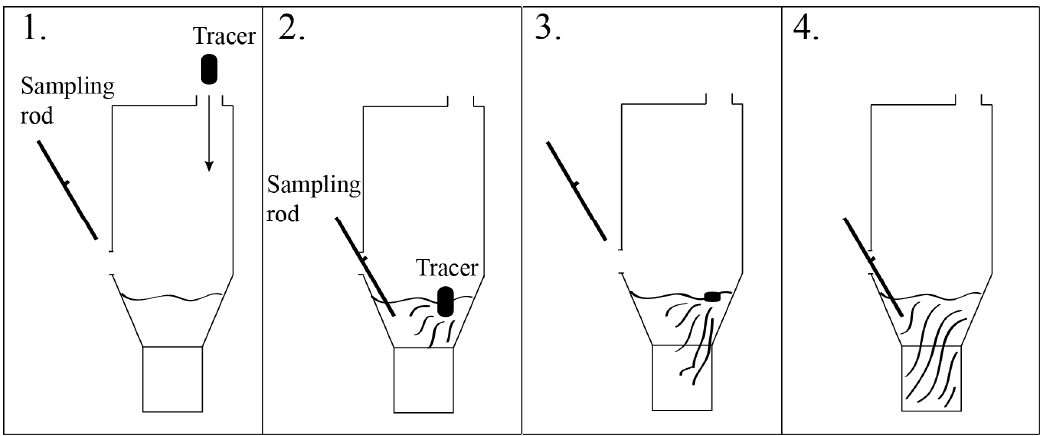
Figure 1. Schematic picture of the sampling procedure with the addition of tracer and sampling rod.